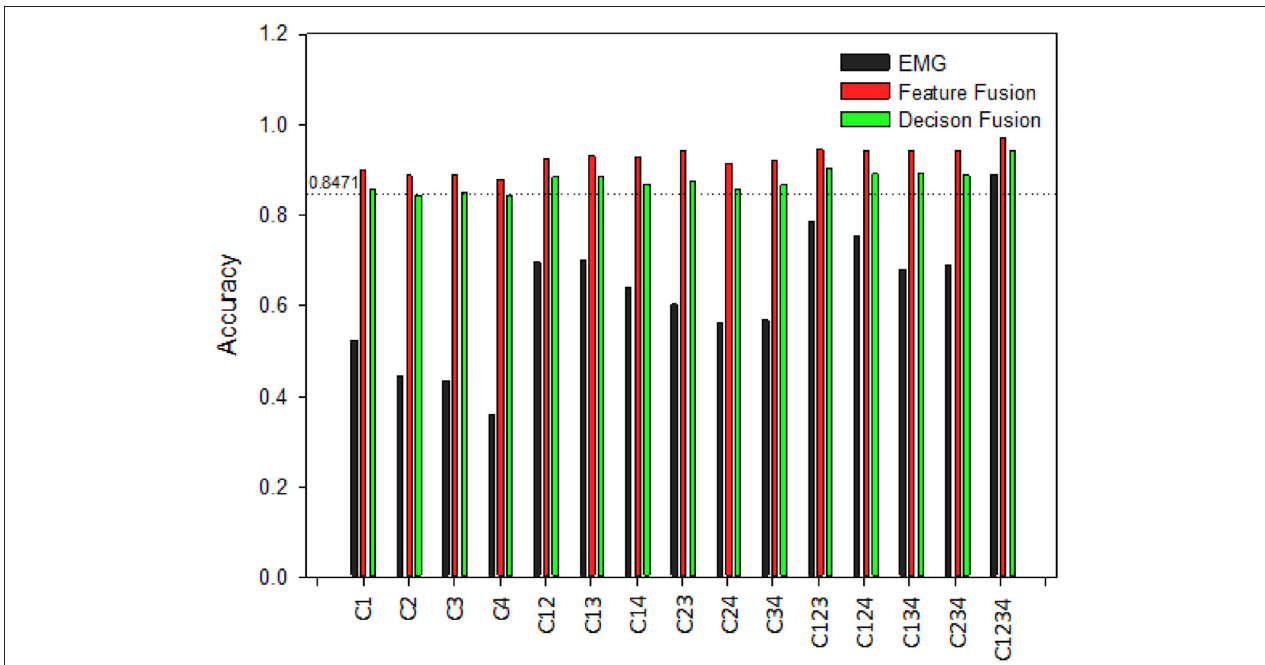
FIGURE 9 | Classification accuracy of different channel combinations for hand pattern recognition for post stroke patients. C1–C4 are recorded from muscles of abductor pollicis brevis, flexor carpi radialis, extensor digitorum, and extensor carpi ulnaris,